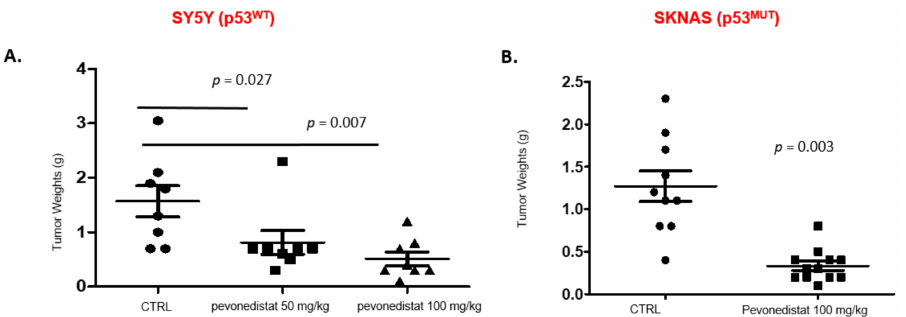
Figure 6. Tumor weights in two orthotopic xenograft models after treatment with pevonedistat. ( A ) Tumor weights in SY5Y orthotopic xenografts treated with either vehicle alone, 50 mg/kg of pevonedistat, or 100 mg/kg of pevonedistat. ( B ) Tumor weights in SKNAS orthotopic xenografts treated with either vehicle alone or 100 mg/kg of